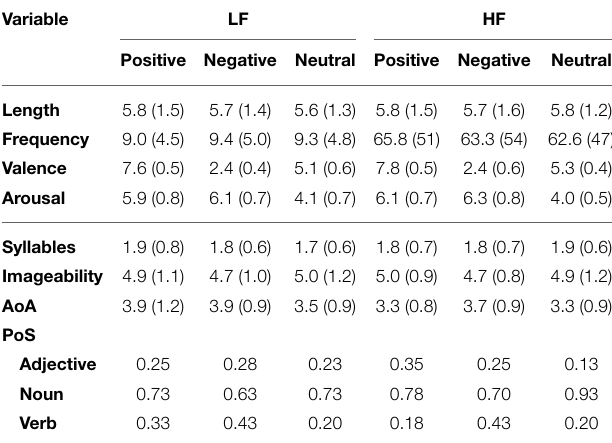
TABLE 2 | Means (with SDs) of target specifications across experimental conditions.